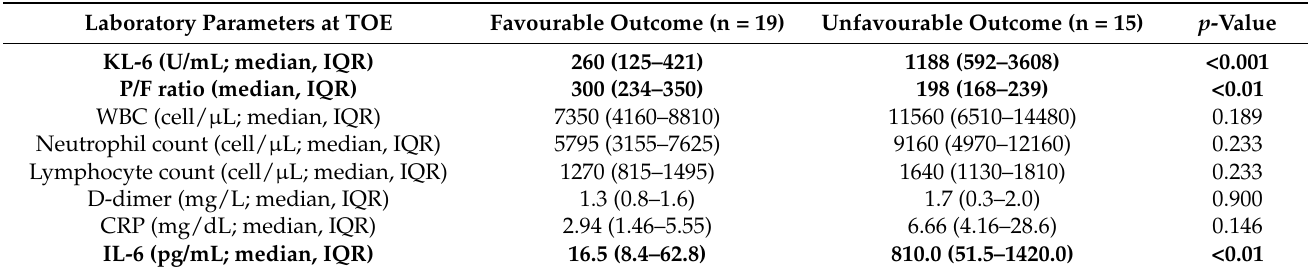
Table 5. Laboratory parameters distribution at TOE among patients with favourable and unfavourable outcomes. Laboratory Parameters at TOE Favourable Outcome (n = 19)